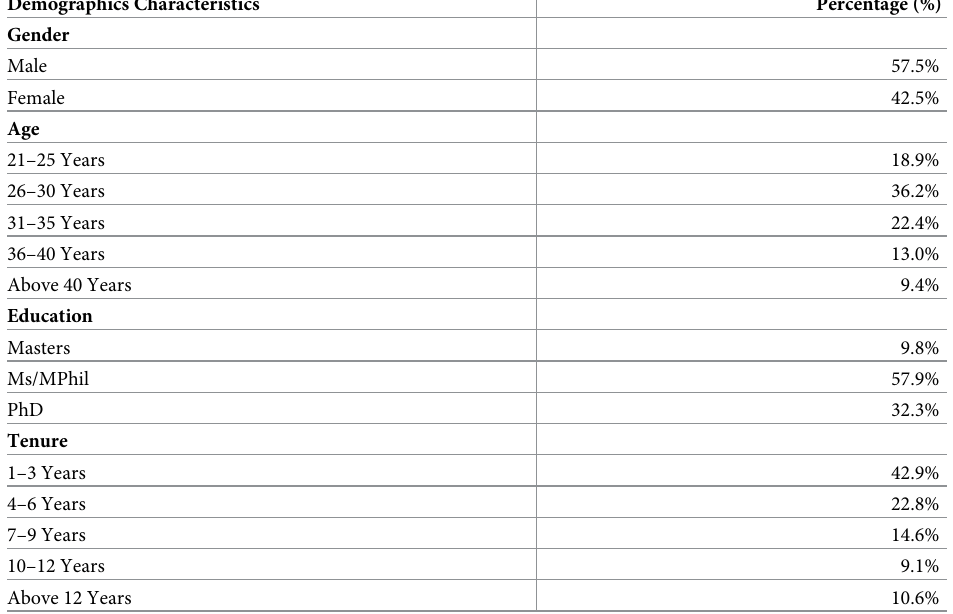
Table 1. Profile of